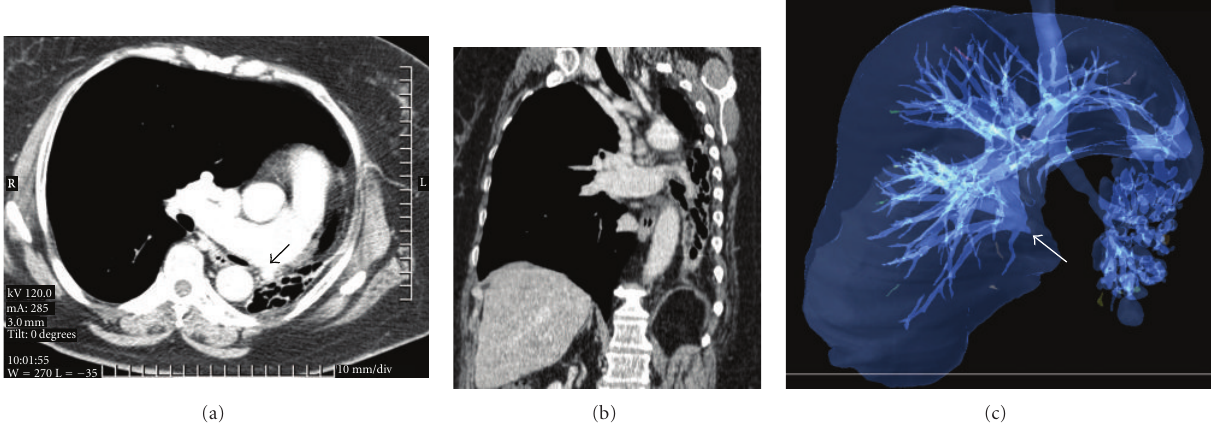
Figure 5: Contrast MDCT illustrates the apparent blind-ended hypoplastic left pulmonary artery (black arrow) and the dilated right pulmonary artery (a); coronal reconstruction visualizes the hypoplastic left pulmonary artery (b), and 3D reconstruction in the “transparency” mode (c) demonstrates the main bronchial orientation, the cystic structure of the left lung and the presence of the functional vascular architecture only in the developed lung (white